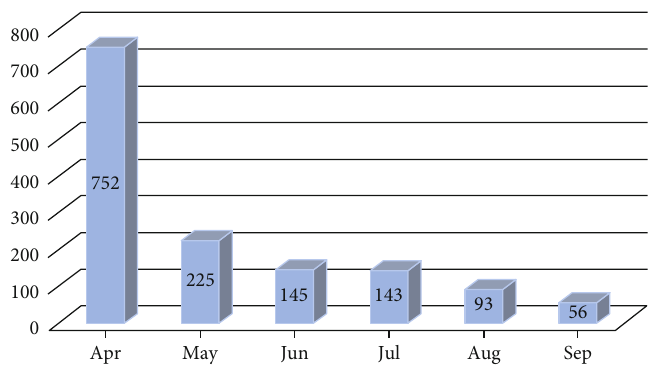
Figure 2: Number of volunteers joining the 937-Call Center between April ∗ and September 2020. ∗ Volunteers joined in March, but the o ffi cial count of volunteers started on April, which includes both Table 3: Change in percentage of calls received by each category of sta ff working in the 937-Call Center between 2019 and 2020 (March to September).